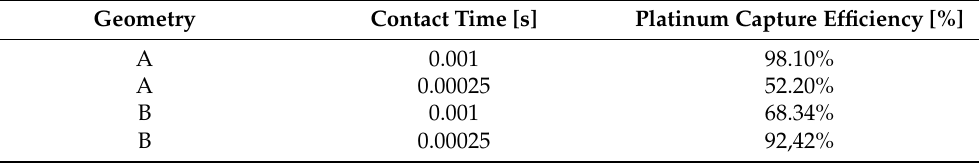
Table 5. Platinum capture efficiencies for the extreme cases in Scenario 2.